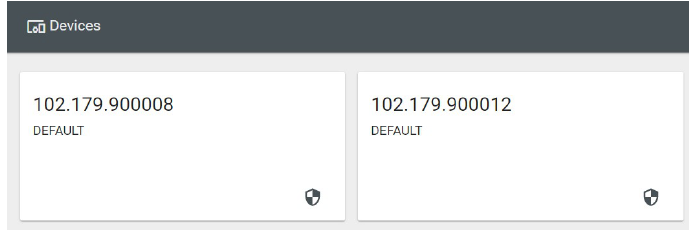
Figure 4. Devices